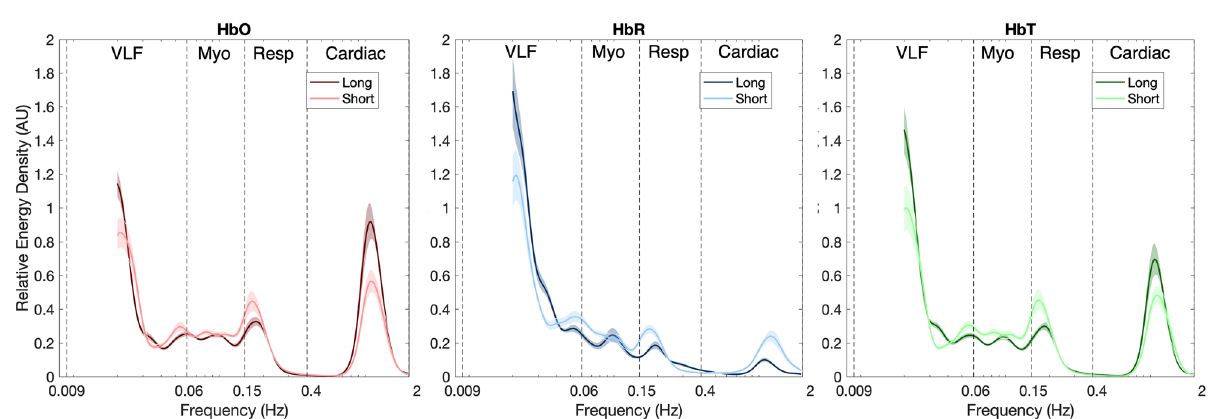
Figure 6. Differences in relative energy density ( rel ε ) between long- and short- source detector separation (SDS) measurements per biomarker during hypercapnic stimulus. Colored lines represent mean of the data (channels and subjects), while associated shaded portions represent standard error of mean. Dashed black lines represent beginning and ending of very low frequency (VLF), myogenic (Myo), respiratory (Resp) and cardiac bands. Figure generated using custom code in Matlab (MathWorks,